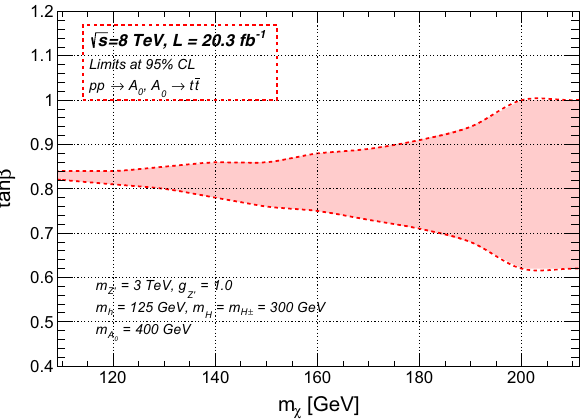
Fig. 5 Upper limit on spin-independent DM-nucleon cross section ( σ SI ) as a function of the DM mass. The exclusion limit of the t ¯ t reso- nance obtained in this paper at 95% CL, is compared with limits from direct detection experiments and from the latest t ¯ t + χ ¯ χ by ATLAS at 90%